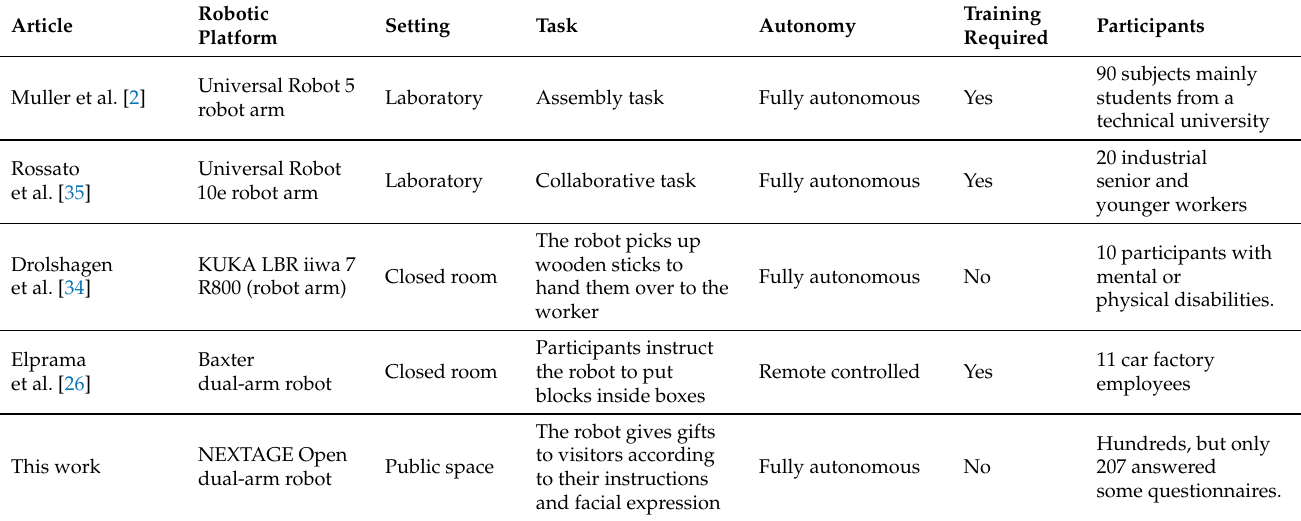
Table 1. Research articles proposing interactive robotic systems with industrial robots for grasping perceptions towards robots after performing direct Human–Robot